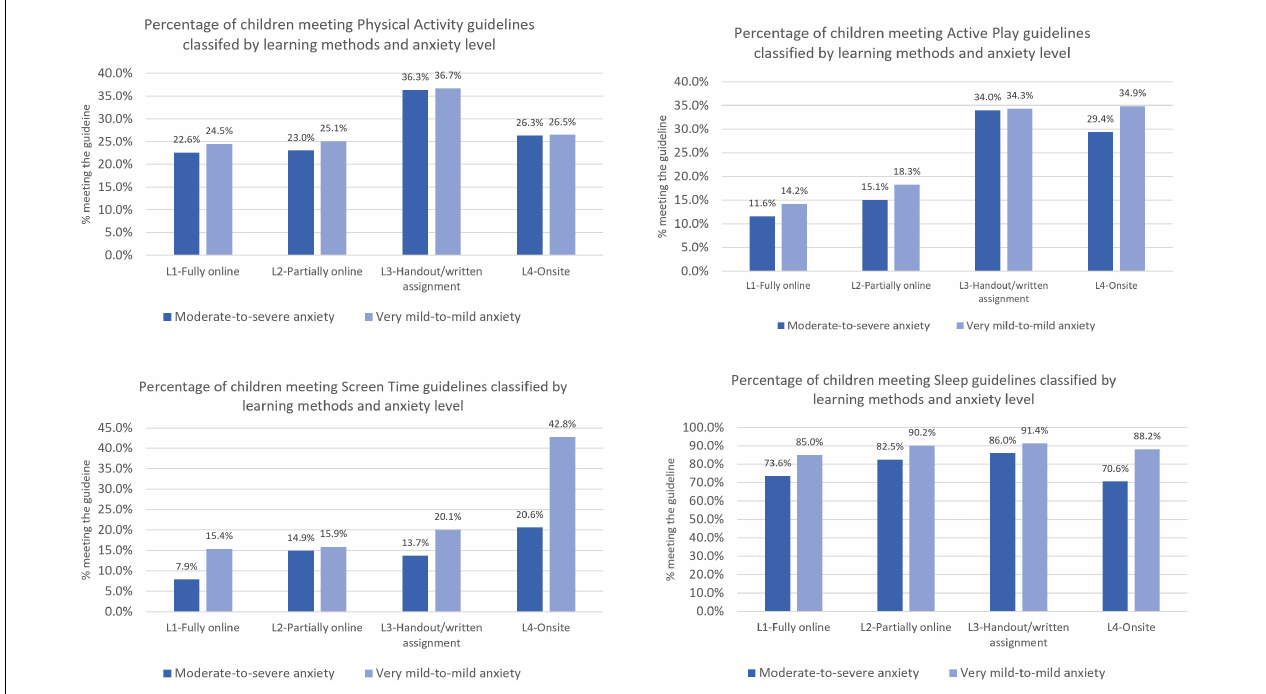
FIGURE 3 | Adjusted proportional percentage of meeting health behavior guidelines by learning method and school closure-induced